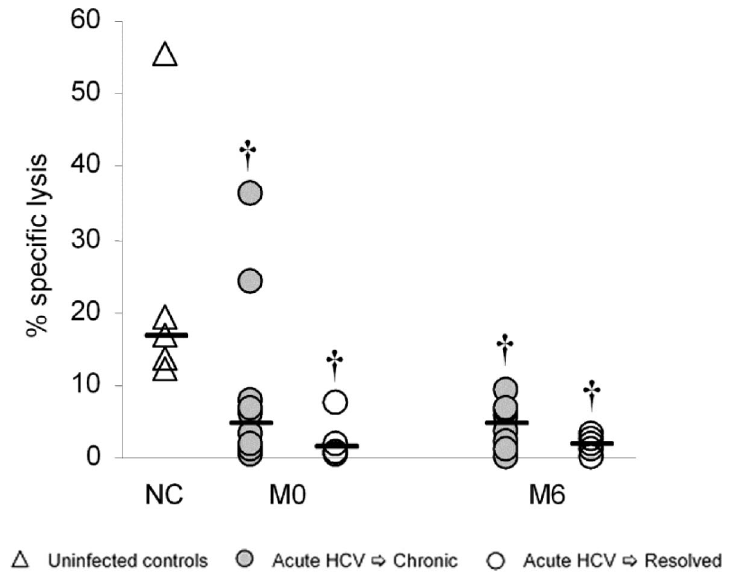
Figure 3. Functional competence of NK cells in acute HCV infection. Natural Cytotoxicity of bead-purified NK cells is compromised both early (M0) and late (M6) in acute HCV infection irrespective of outcome. * p , 0.05 chronic versus resolved; { p , 0.05 versus uninfected control (MWU) Abbreviations: NC=normal control; M=month.